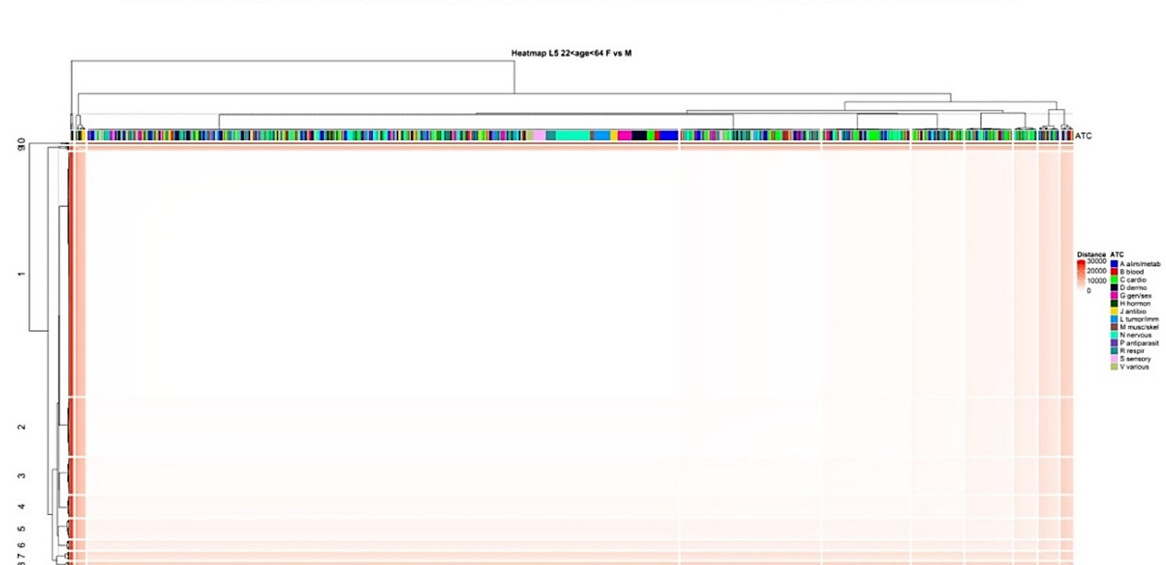
Figure A9. Distance matrices for three ATC levels to compare females vs. males at the 22–64 years age strata. The colour in entry ( 𝑖 , 𝑗 ) is the Euclidean distance between layers 𝑖 (females) and 𝑗 (males) of the binary DPN. Euclidean distances are coded by colours from white (small distance) to red (large distance). Nodes are coloured according to the 14 groups found at the first level of the ATC classification system. Dendrograms identify a number of clusters in the distance matrices.